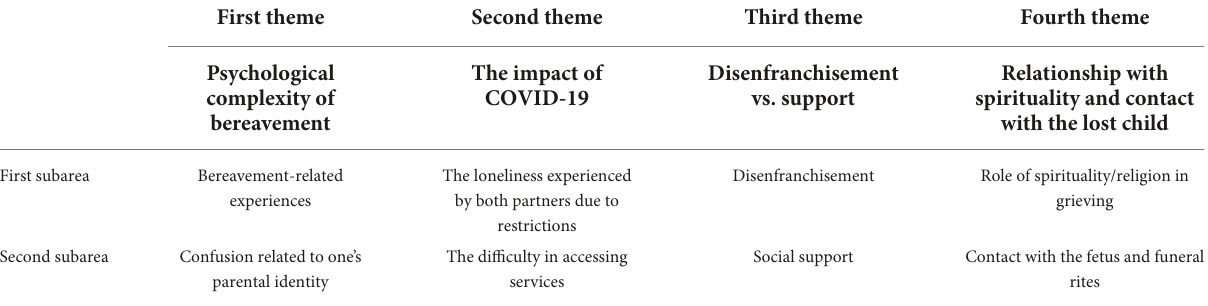
TABLE 2 Thematic areas and sub-areas emerging from the qualitative